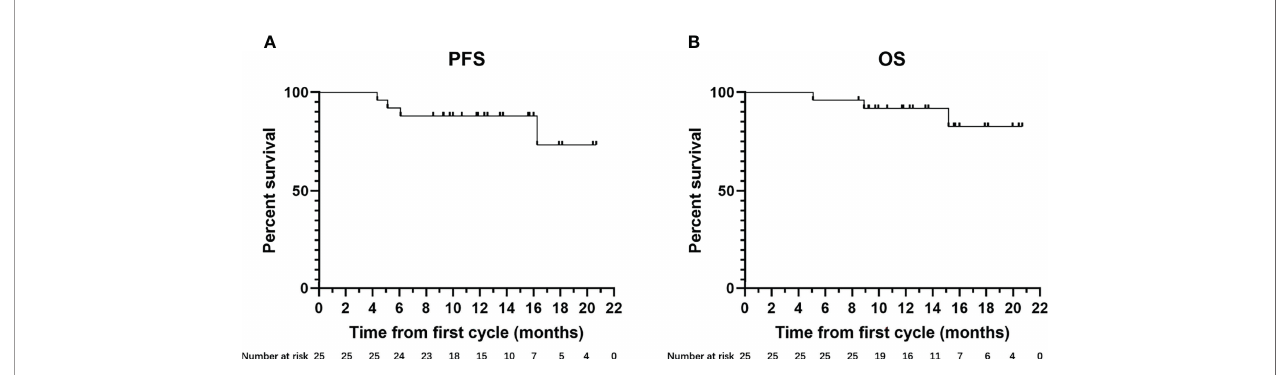
FIGURE 2 | Kaplan-Meier estimates of (A) progression-free survival (PFS) by modi fi ed RECIST (n = 25) and (B) overall survival (OS) (n = 25).